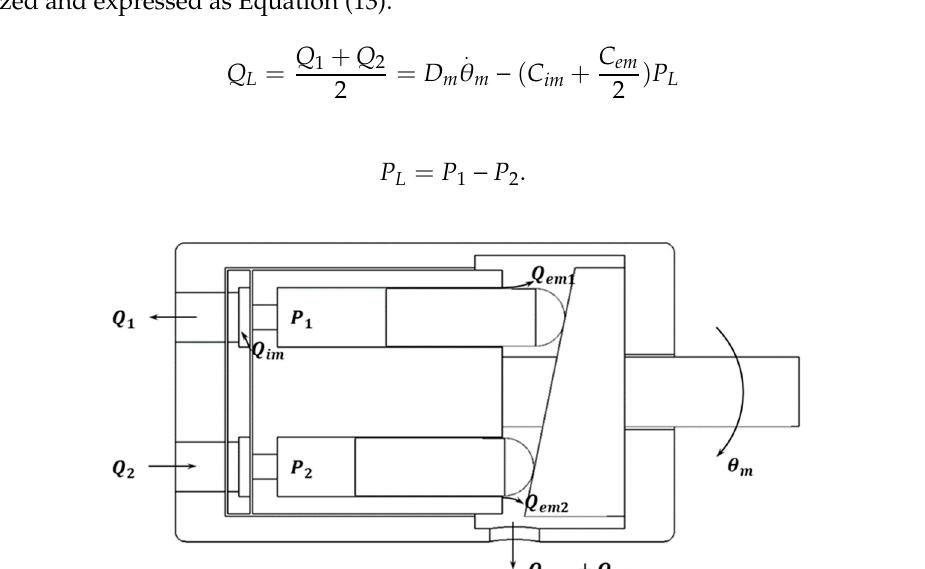
Figure 6. Schematic diagram of an axial-piston pump: cam plate; shaft; cylinder block and piston shoes; cylinder valve.